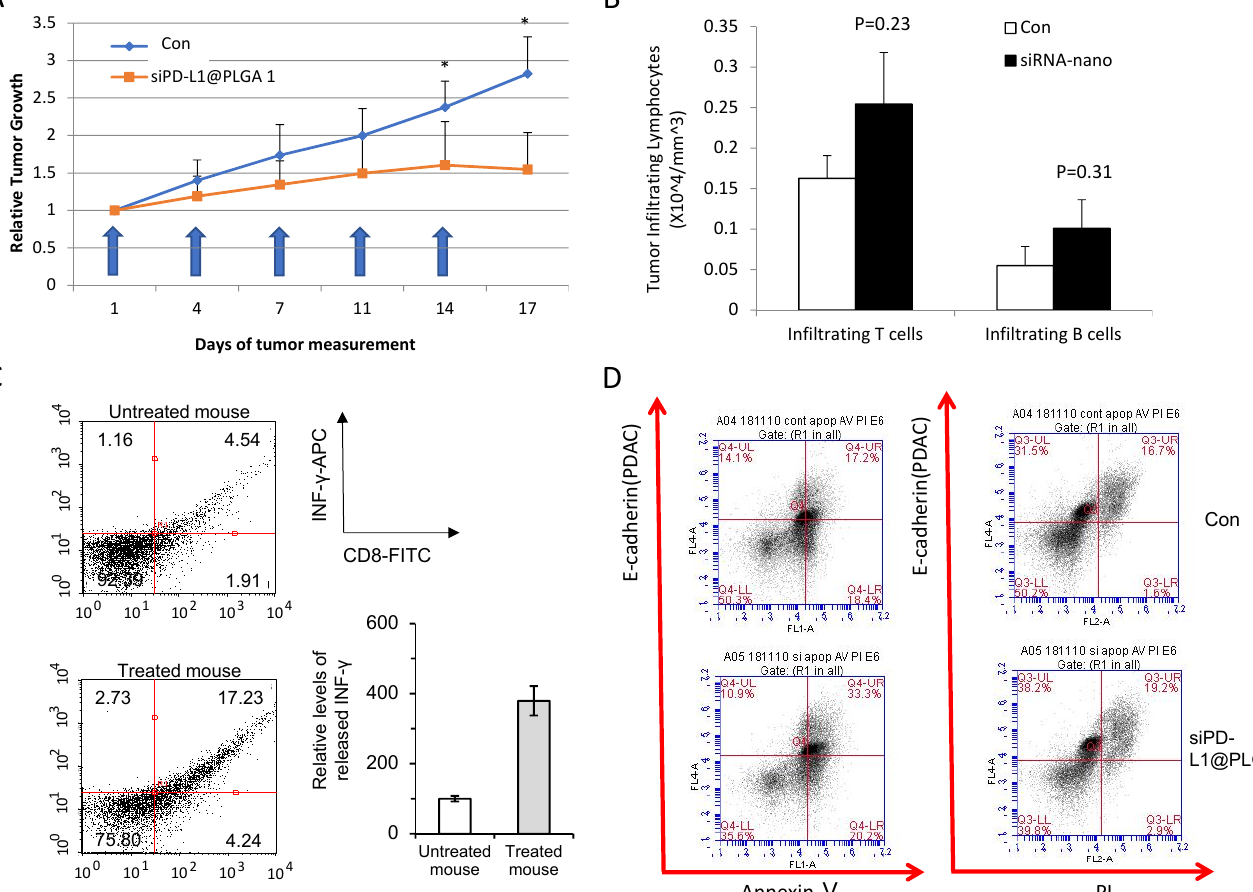
Figure 4. siPD-L1@PLGA suppressed PDAC growth in the humanized NSG mouse model. ( A ) Graph showing the growth of control (PBS, in blue) and siPD-L1@PLGA-treated (orange) PDAC in the humanized NSG mouse. Blue arrows indicate siPD-L1@PLGA injection. The p -values of <0.05 was denoted as *. ( B ) Tumor-infiltrating lymphocytes. Densities of T cells (hCD45 + hCD3 + ) and B cells (hCD45 + hCD19 + ) in the PDAC tumor burden. Data are expressed as the mean ± SD ( n = 4–5 mice/group). “ns” indicates a “not significant” result for the two-tailed unpaired Student’s t -test. ( C ) FACS histograms for the production of IFN- γ in the tumor antigen-stimulated CD8 + T cells. The isolated CD8 + T cells from